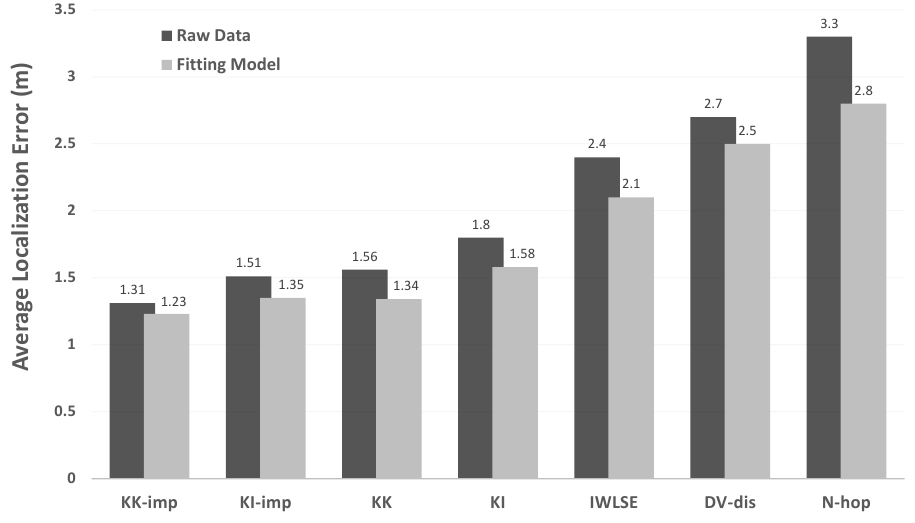
Figure 17. Mean localization errors for all the localization algorithms under the two RSSI measurement